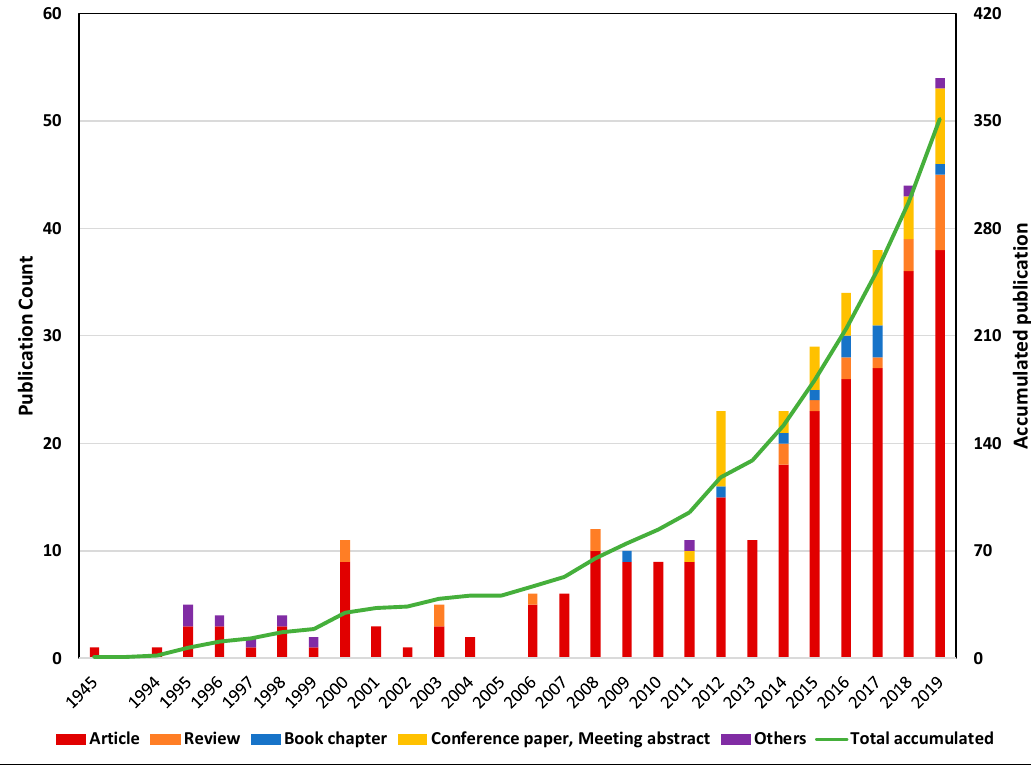
Figure 1. Kombucha publication trend. Kombucha publication types and their counts are shown with accumulated publication number per year from 1945 to 2019.